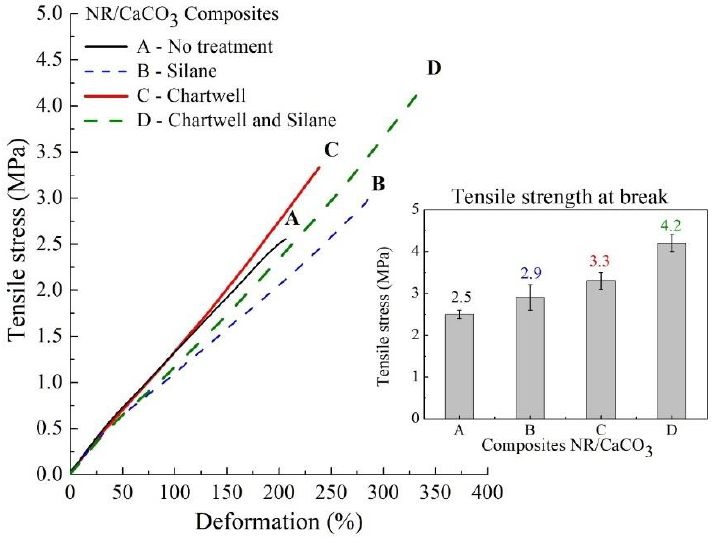
Figure 4. Tensile strength test results of the NR composites with 40 phr of calcium carbonate (CaCO 3 ) under a deformation speed of 500 mm min −1 and a load cell of 1000 kN. Only the coupling agents were changed.